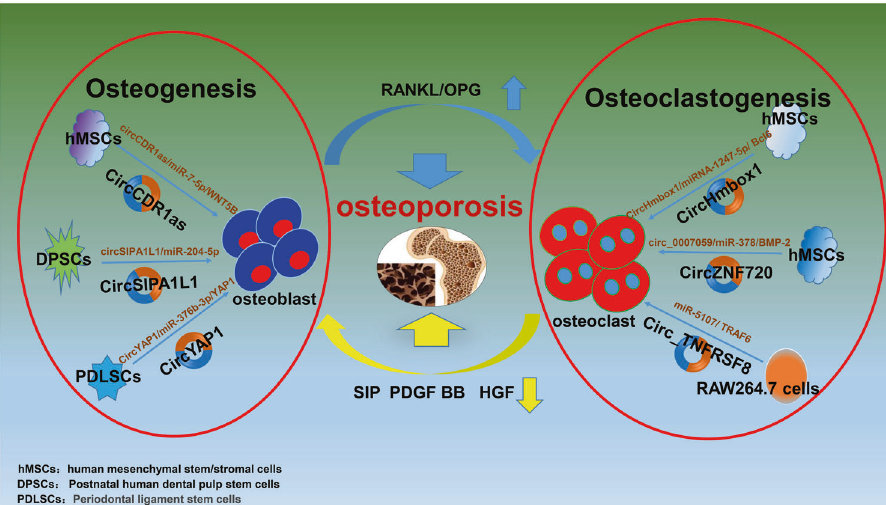
Fig. 3 A diagram brie fl y summarized the circRNAs that are implicated in the dynamic balance between osteogenesis and osteoclastogenesis. PDGF platelet-derived growth factor, HGF hepatic growth